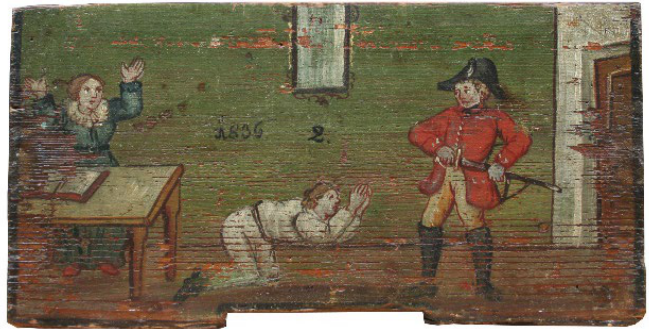
Figure 1. Image of the painted beehive panel.